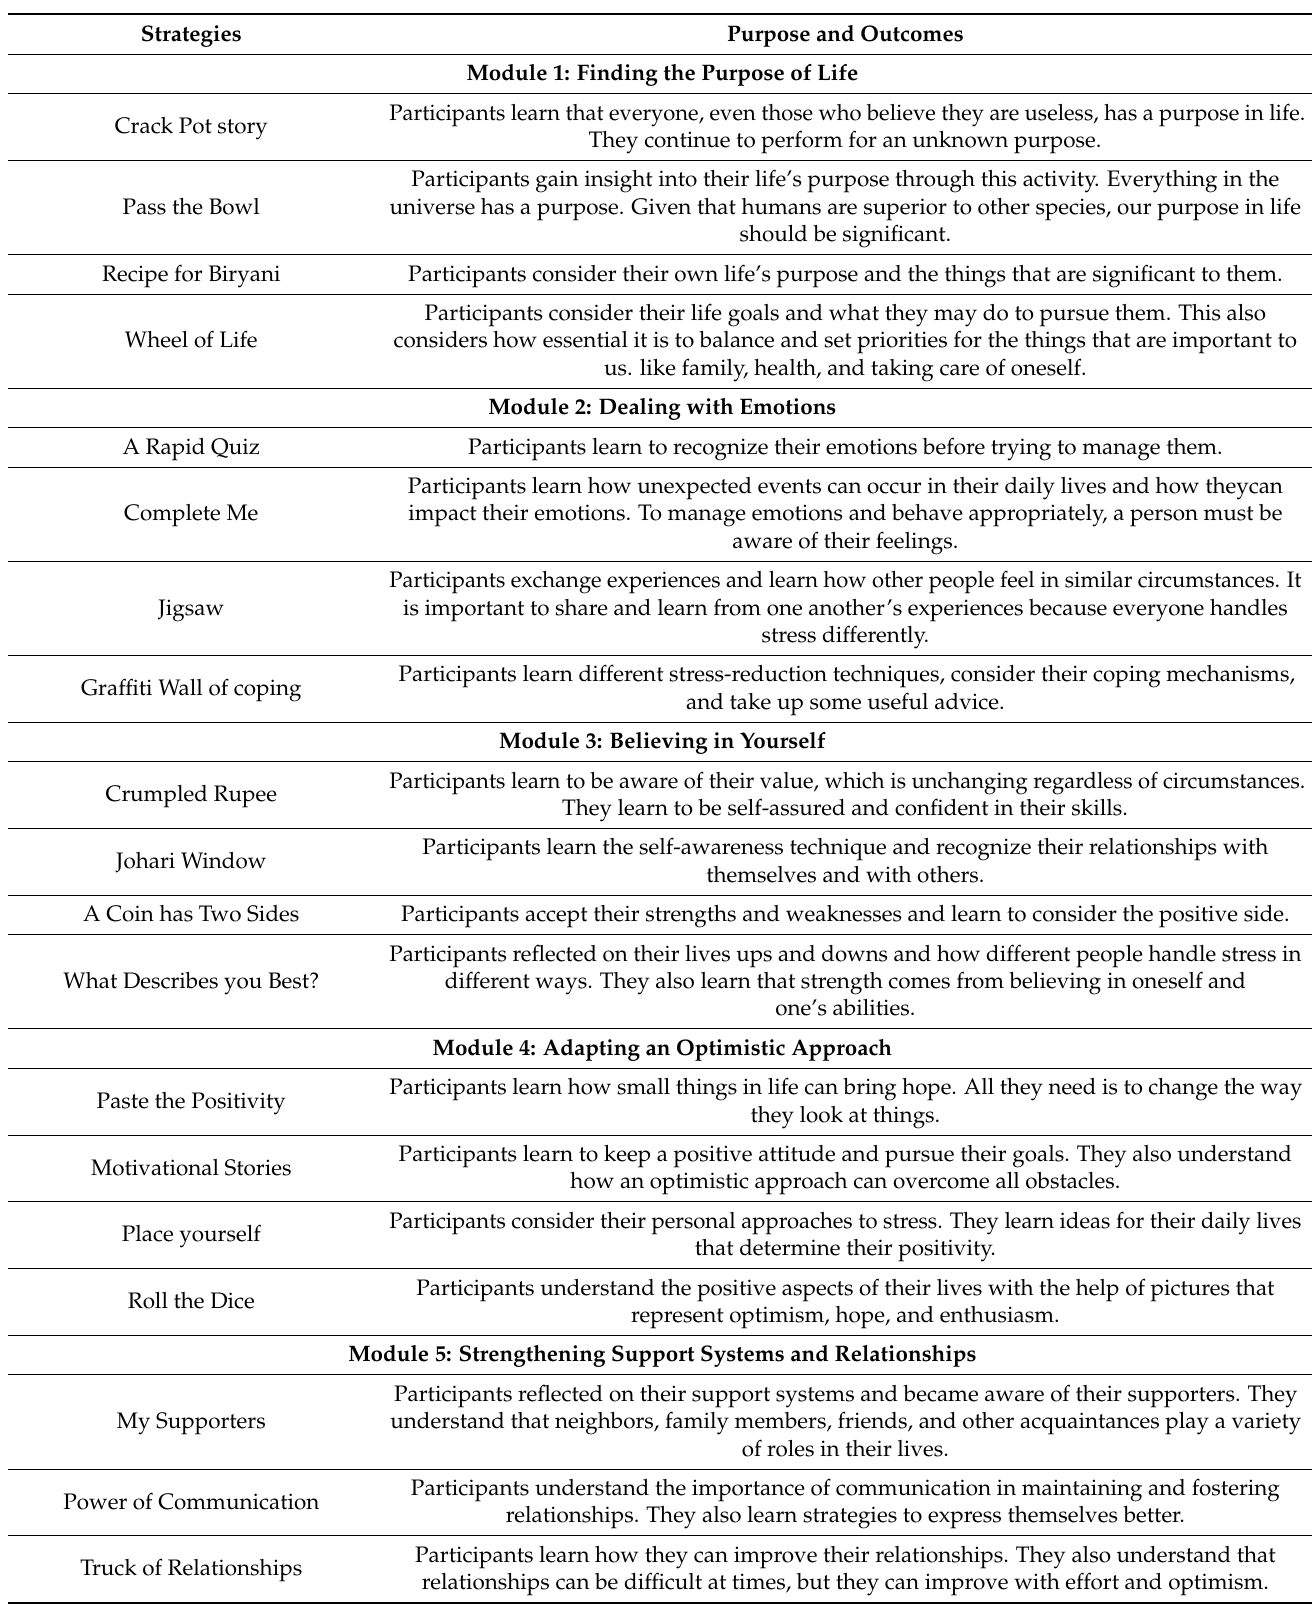
Table 2. Modules’ Strategies—purpose and